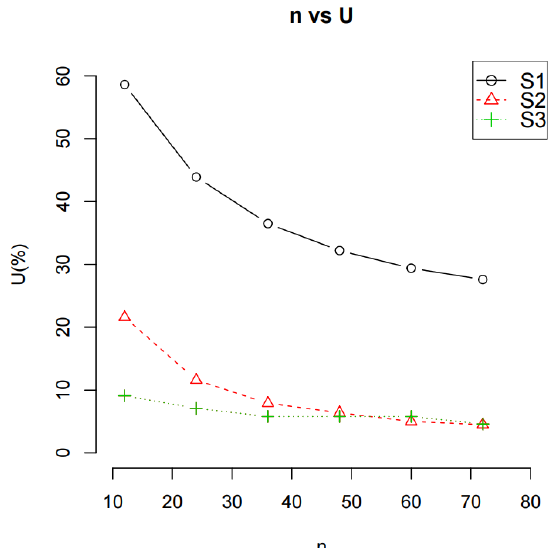
Figure 1. The effect of the size of the dataset ( n ) on the values of U.